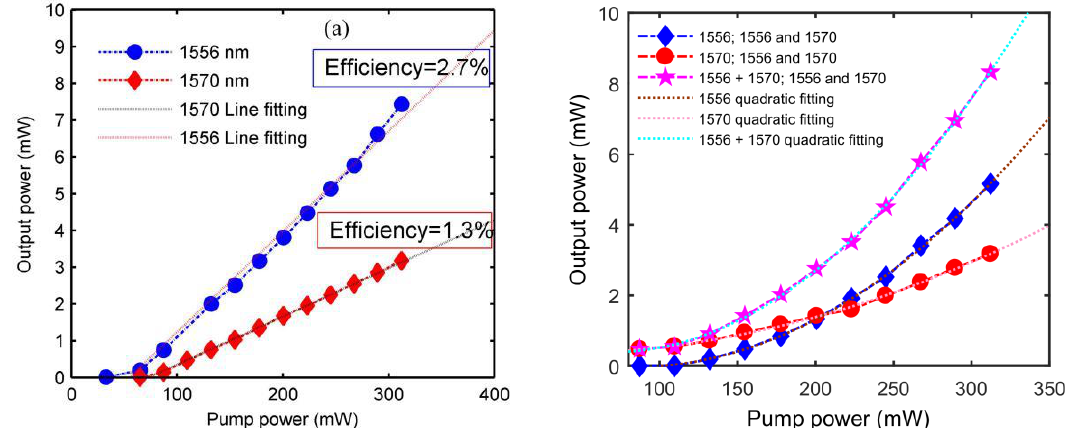
Figure 10. The output efficiency test results of the laser: ( a ) single wavelength output and ( b ) dual- wavelength output.